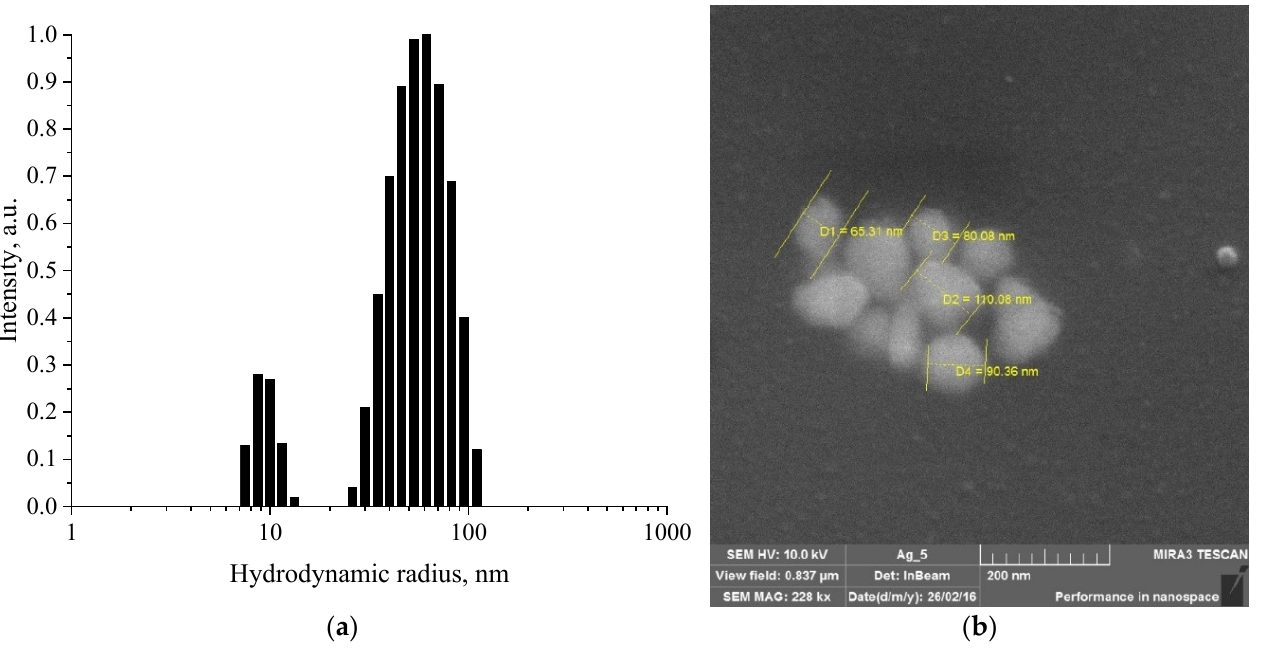
Figure 1. Histogram of Ag NPs hydrodynamic radius distribution ( a ) and SEM micrograph of a dried sample of Ag NPs ( b ).